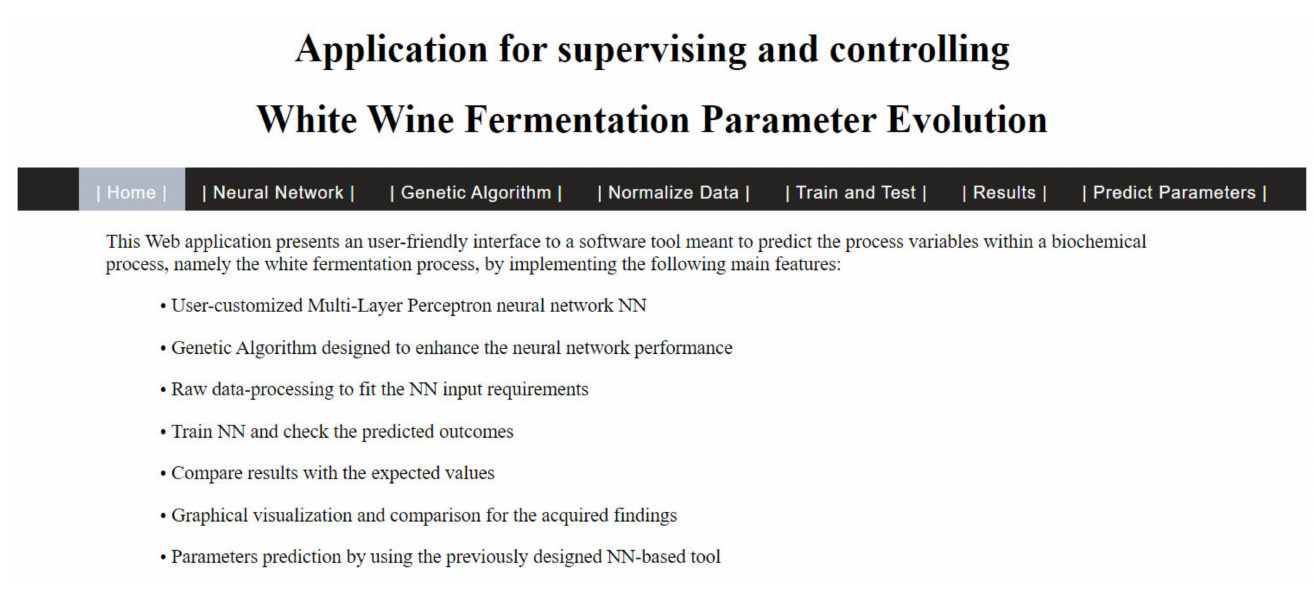
Figure 2. Web application home